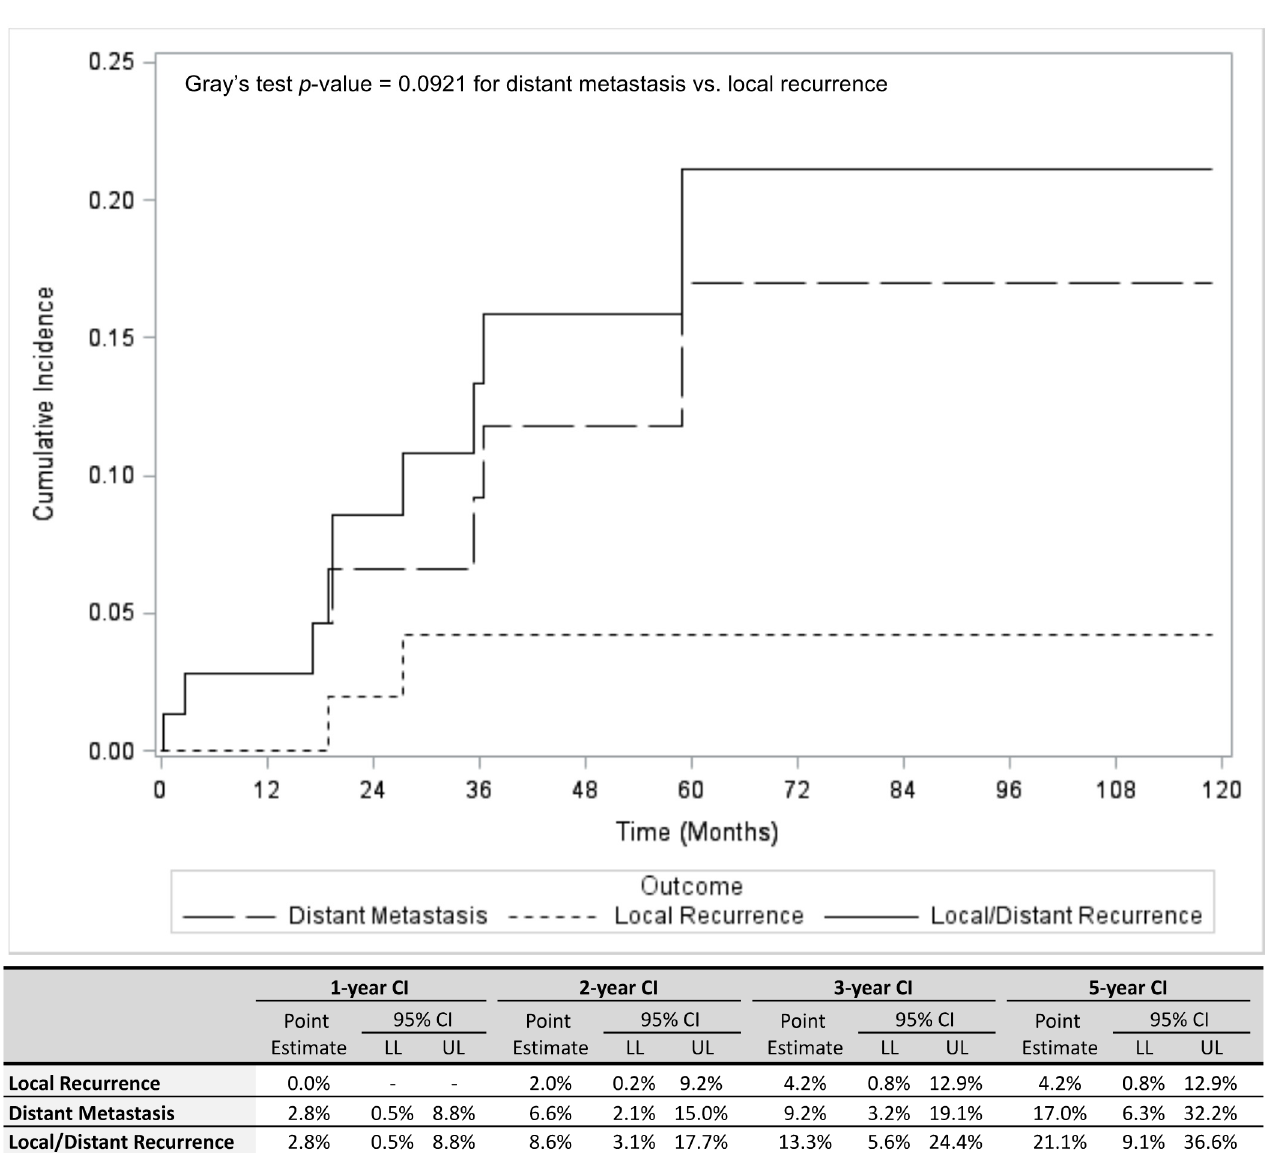
Figure 1. Cumulative incidence (CI) of distant metastasis, local recurrence, and combined distant metastasis and local recurrence is shown (top panel), including estimates for 1, 2, 3, and 5 years (bottom panel) in patients with Class 1A UM. Abbreviations: HR, Hazard ratio; LL, Lower limit; UL, Upper Limit; CI, Confidence interval; Cumulative incidence.